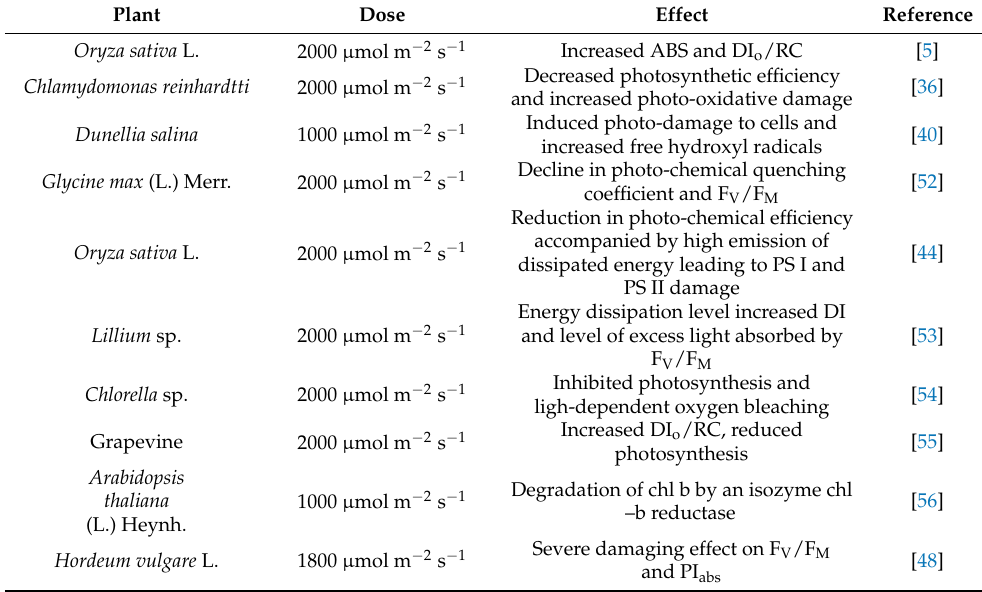
Table 1. Impact of high light exposure on the chlorophyll a fluorescence parameters of different plants. Plant Dose Effect